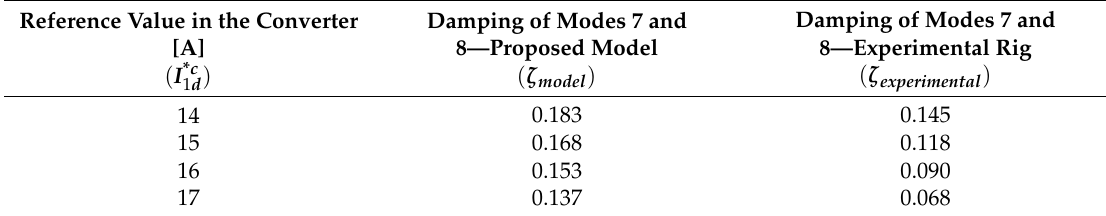
Table 9. Comparison between the damping of modes 7 and 8 given by the proposed model and the those found in the experimental system, for SCR = 1.8577 and PLL bandwidth equal to 40.723 Hz. Reference Value in the